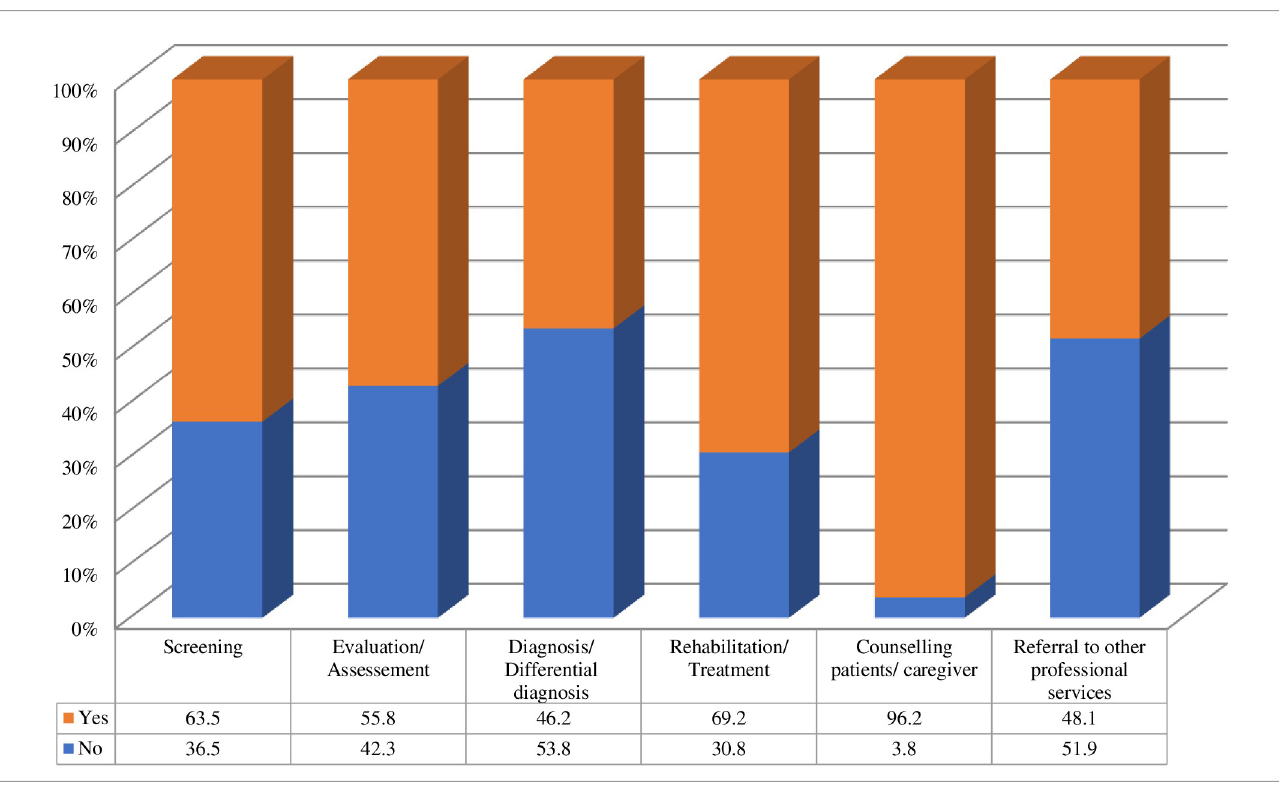
Fig 2. What services did/do you use with your patients via telehealth? (n =